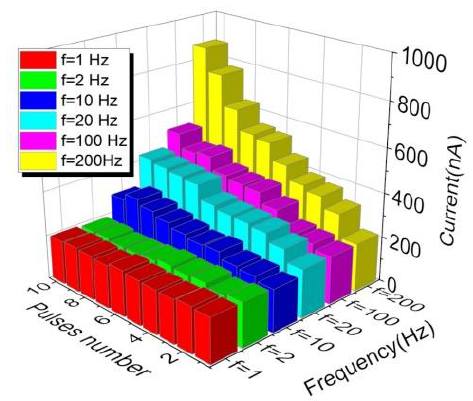
Figure 9. Current tunability upon stimuli frequency for the NP-embedded devices.